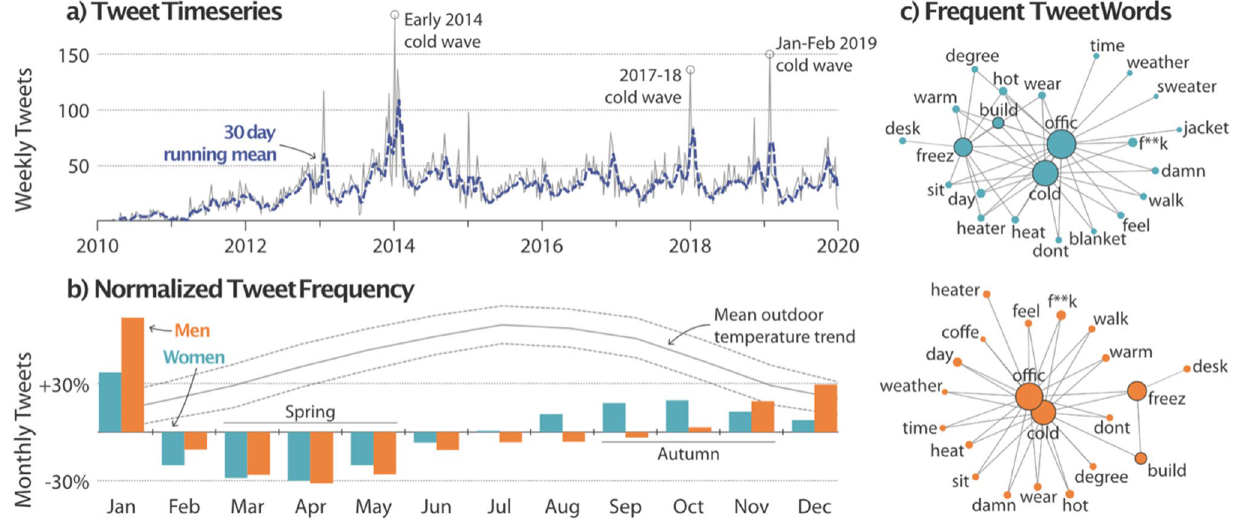
Figure 2. Cold office tweets. Twitter activity from US office occupants who are cold in their workspace. ( a ) The weekly number of tweets over the 10-year period that met the criteria for inclusion in this study. Notable meteorological events are labelled and show the corresponding increase in cold office tweets. ( b ) Normalized monthly tweet activity by gender. We calculated the change in Twitter activity each month relative to the total count of cold office tweets divided by the number of months. There is a relative increase in activity starting in July for women and in October for men. Both genders have the highest number of cold office tweets in January. The mean (solid), minimum (dashed), and maximum (dashed) outdoor temperature trend is shown for reference. ( c ) Network graph of the paired word frequencies of the cold office tweets for women (top) and men (bottom). Search keywords (office, cold, building, freezing) are outlined in grey and sit at the center of the network plot. More frequent words have larger points and less frequent words have smaller points; search keywords were most frequent. Lines show the common term pairs between frequently used words. The layout of points is to reduce overlap and is not statistically meaningful. Many term pairs are similar by gender, but women discussed cold weather clothing items like sweater, jacket, and blanket whereas men did not. Network graph produced using 38